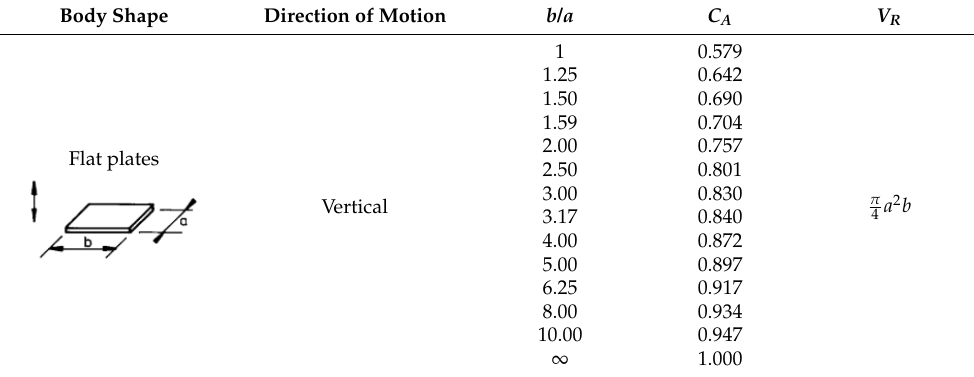
Table A3. Added mass data for the flow perpendicular to the flat plate (reproduced from [48], with permission from DNV, 2021).